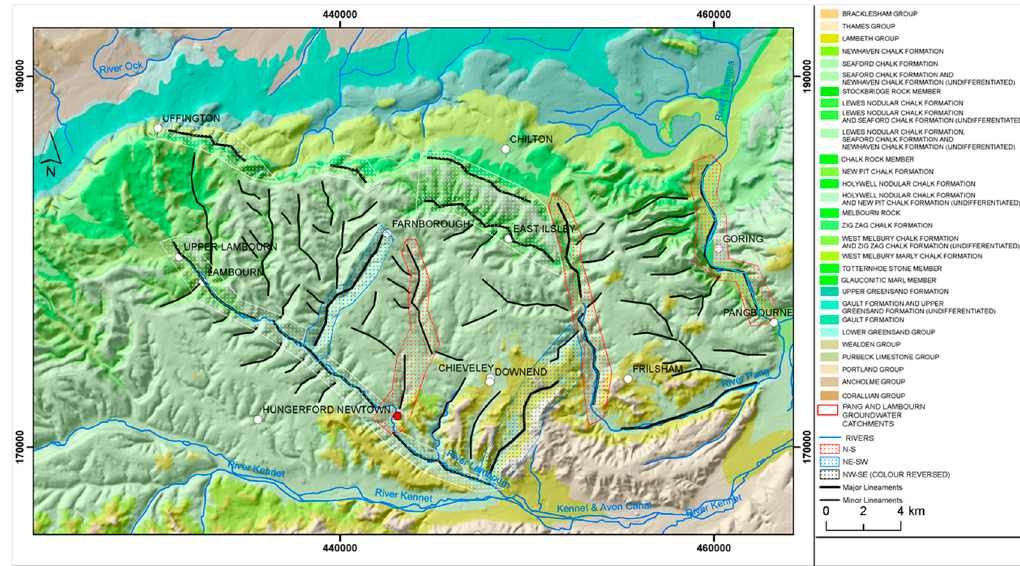
Figure 1. Dry valley features of the Lambourn catchment. The location of the Boxford wetland is marked with a red circle. The dry valley surface topographic catchment is shown shaded to the north of the wetland. Figure reproduced with permission of the British Geological Survey.